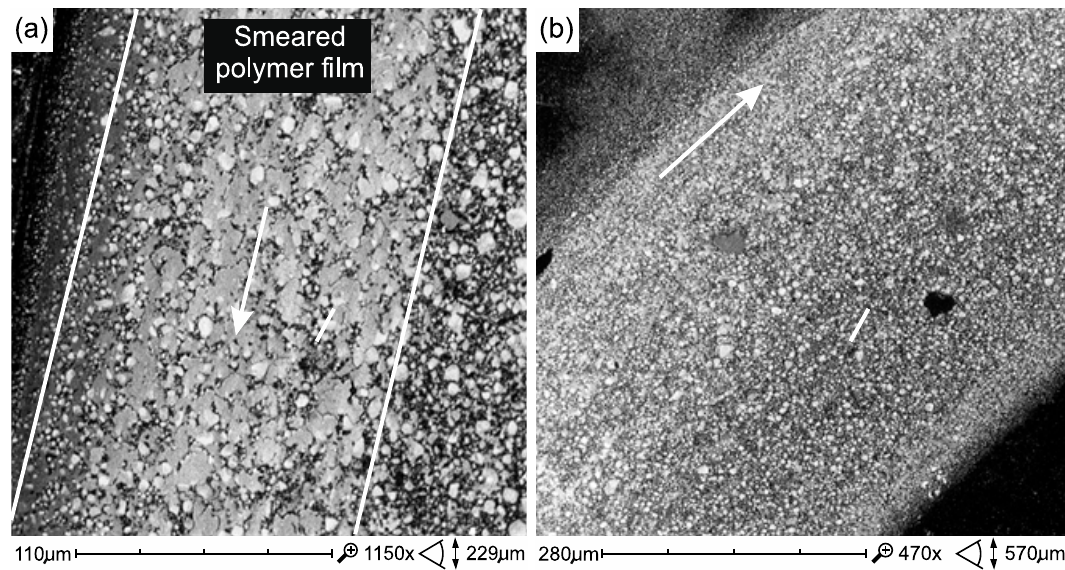
Figure 14. The friction surface of FFlow composite samples without ( a ) and after thermocycling ( b ). Direction of sliding marked by an arrow.